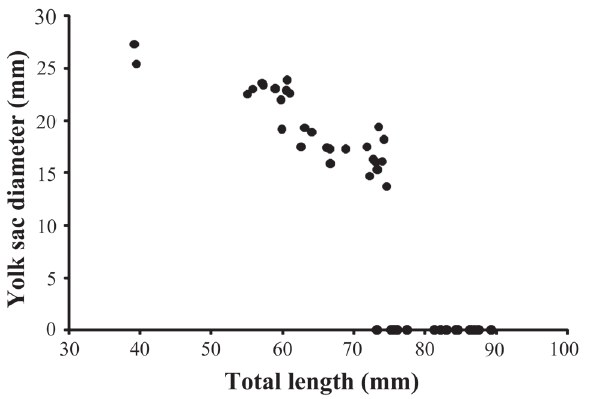
Fig. 10. Relationship between total length (TL (W ) for embryos of Discopyge tschudii . W e 2.63 ; R 2 = 0.80; n= 178. 10 -0.5 X TL e